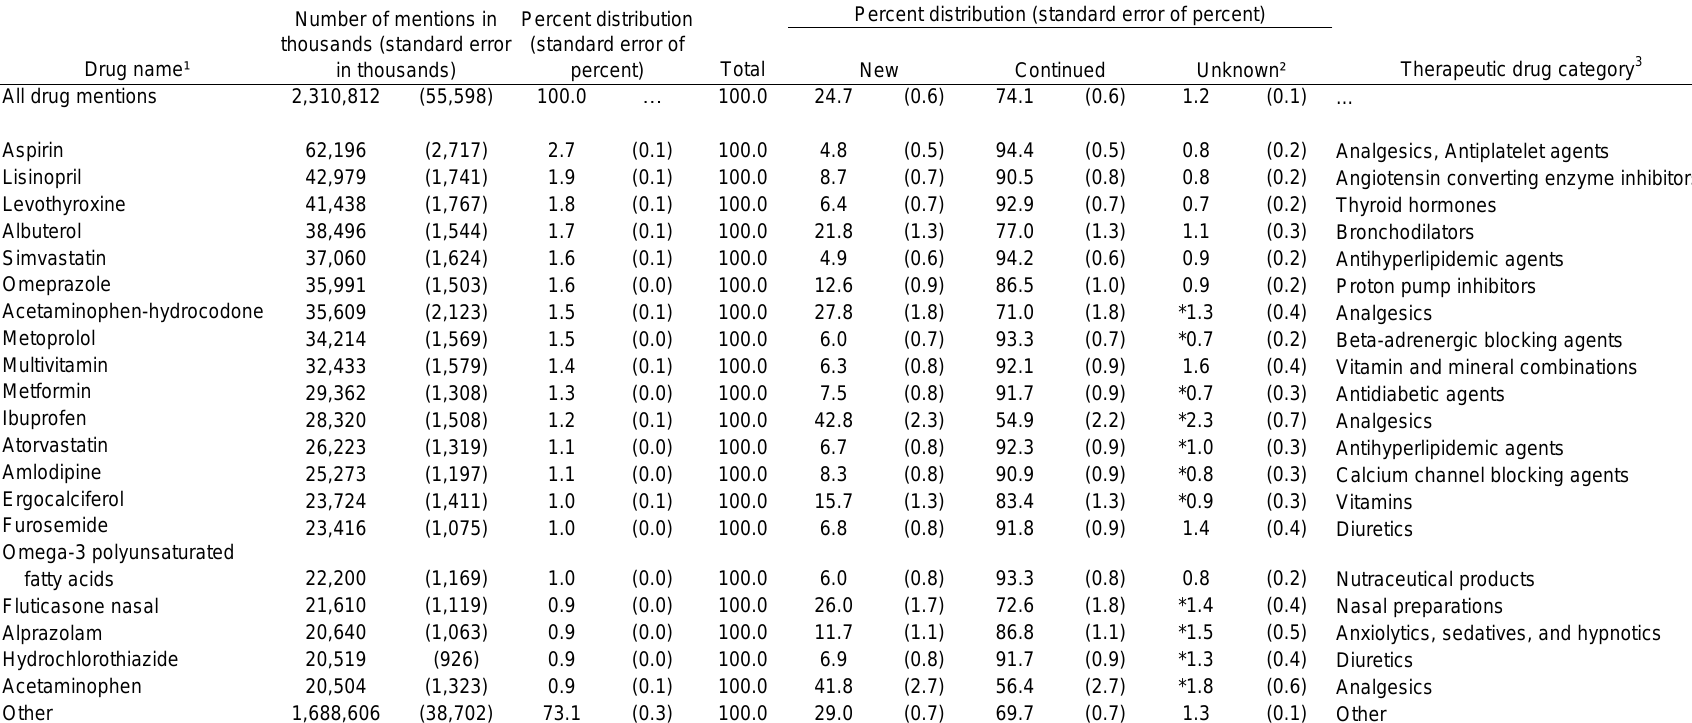
Table 26. Twenty most frequently mentioned drug names at office visits, by new or continued status: United States, 2012